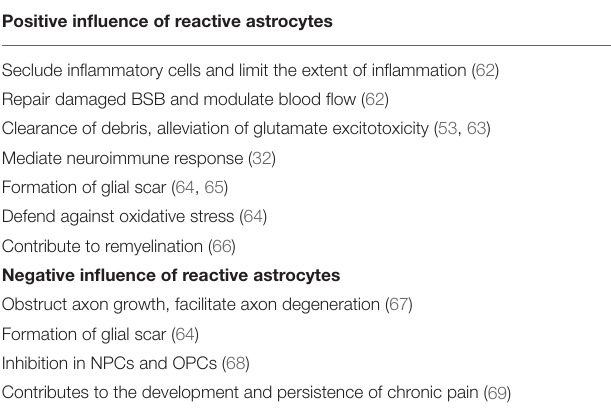
TABLE 3 | Positive and negative influence of reactive